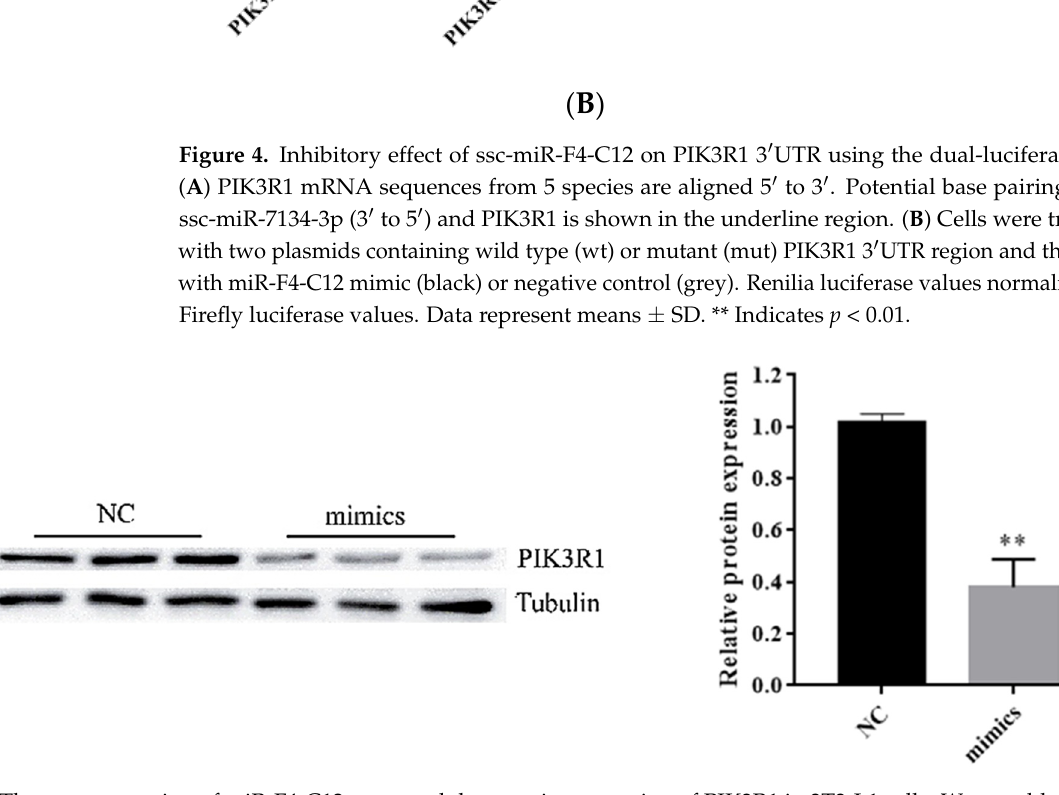
Figure 4. Inhibitory effect of ssc-miR-F4-C12 on PIK3R1 3’UTR using the dual-luciferase system. ( A ) PIK3R1 mRNA sequences from 5 species are aligned 5 ′ to 3 ′ . Potential base pairing between ssc- miR-7134-3p (3 ′ to 5 ′ ) and PIK3R1 is shown in the underline region. ( B ) Cells were transfected with two plasmids containing wild type (wt) or mutant (mut) PIK3R1 3 ′ UTR region and then treated with miR-F4-C12 mimic (black) or negative control (grey). Renilia luciferase values normalized to the Firefly luciferase values. Data represent means ± SD. ** Indicates p < 0.01.